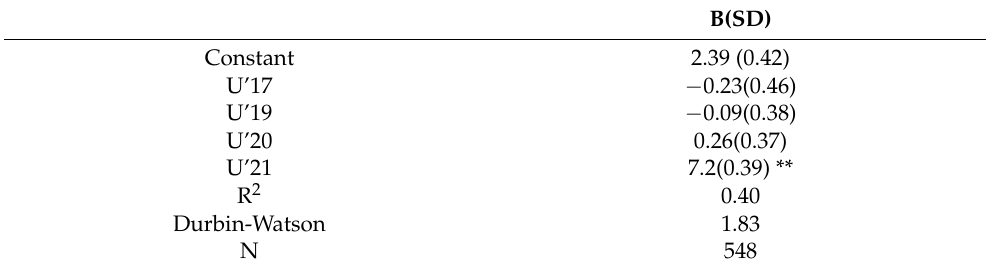
Table 5. Linear regression between Spanish national youth teams and football games played in the first division.